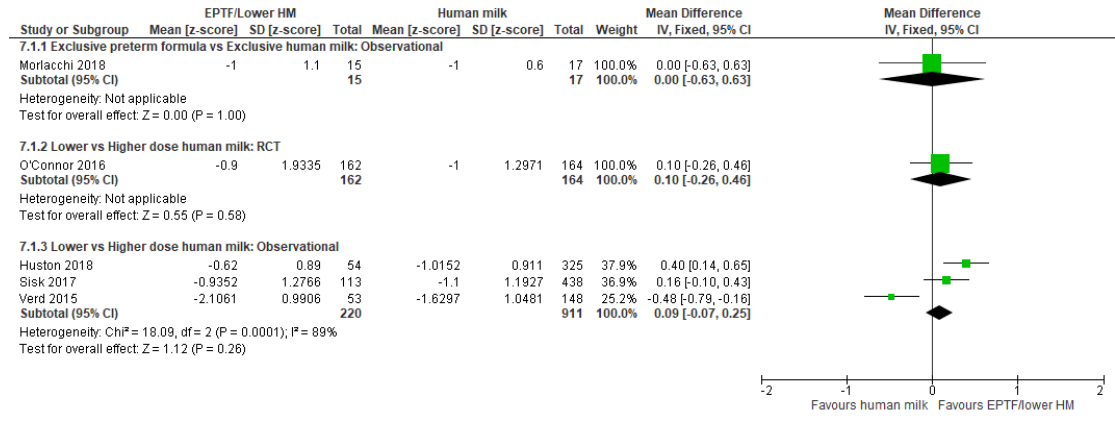
Figure 7. Forest plot of mean difference in change in length z-scores and human milk intake. Overall: The evidence for an effect of feeding EPTF vs. EHM on length gain is incon- clusive.